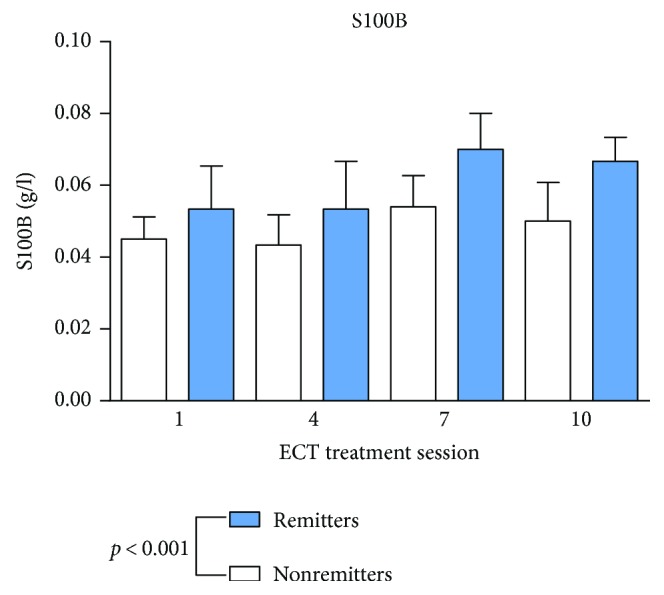
 S100B serum levels in remitters and nonremitters. Mixed linear modelling showed significantly higher serum levels of S100B in remitted patients. The p value given in the figure is derived from mixed linear modelling. Error bars show the standard error of the mean (SEM).